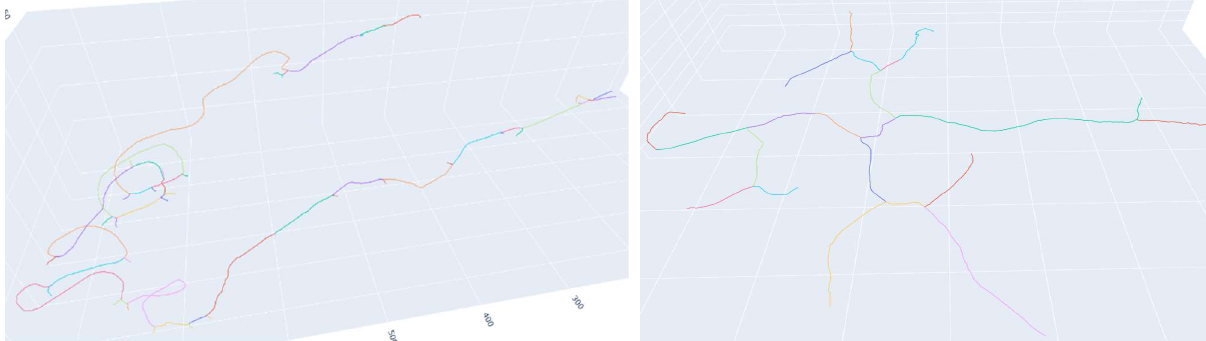
Figure 5. 3D skeleton of the IMI Fabi mine (left), and of the Monte Celva (right), obtained from the CSD algorithm.